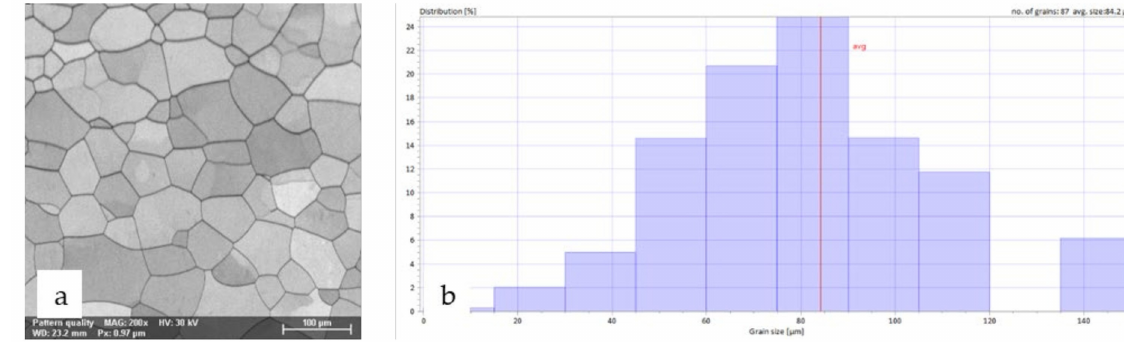
Figure 6. SEM microstructure ( a ) and the distribution of grain size ( b ) of the Ti29.3Nb13.6Zr1.9Fe alloy in as cast state.